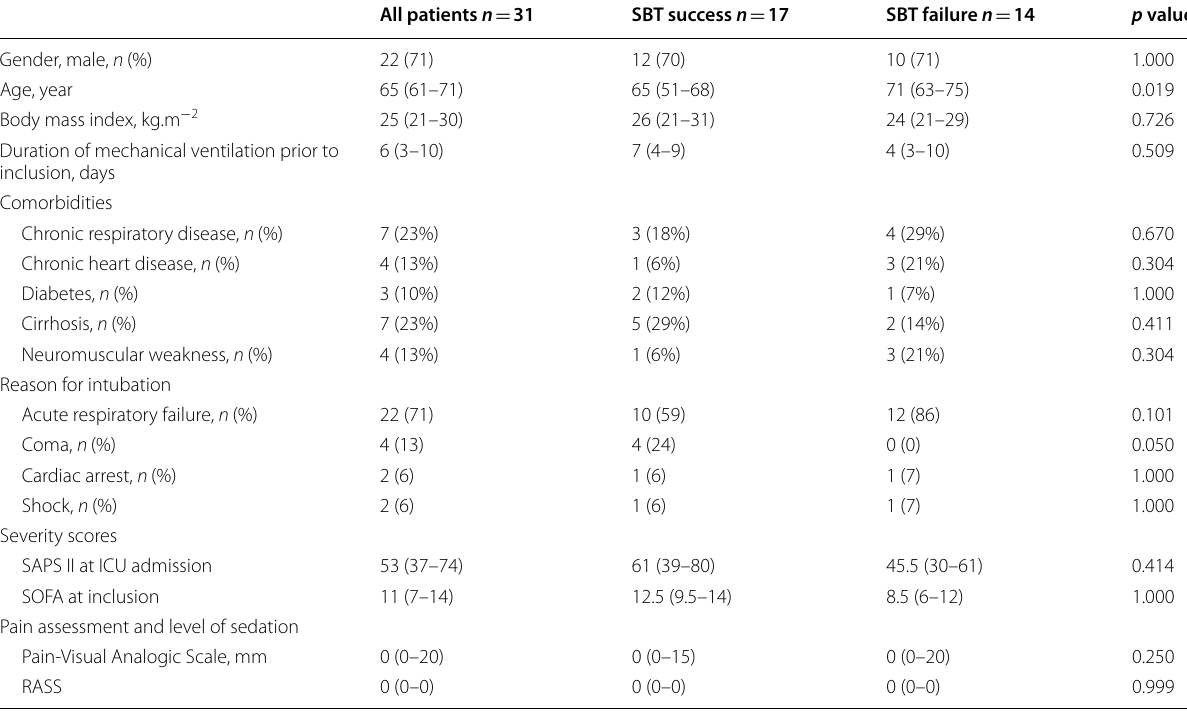
Data are provided as median (interquartile range) and number (%) SBT spontaneous breathing trial; ICU intensive care unit; SAPS Simplified Acute Physiology Score; SOFA Sepsis-related Organ Failure Assessment; RASS Richmond Agitation Sedation